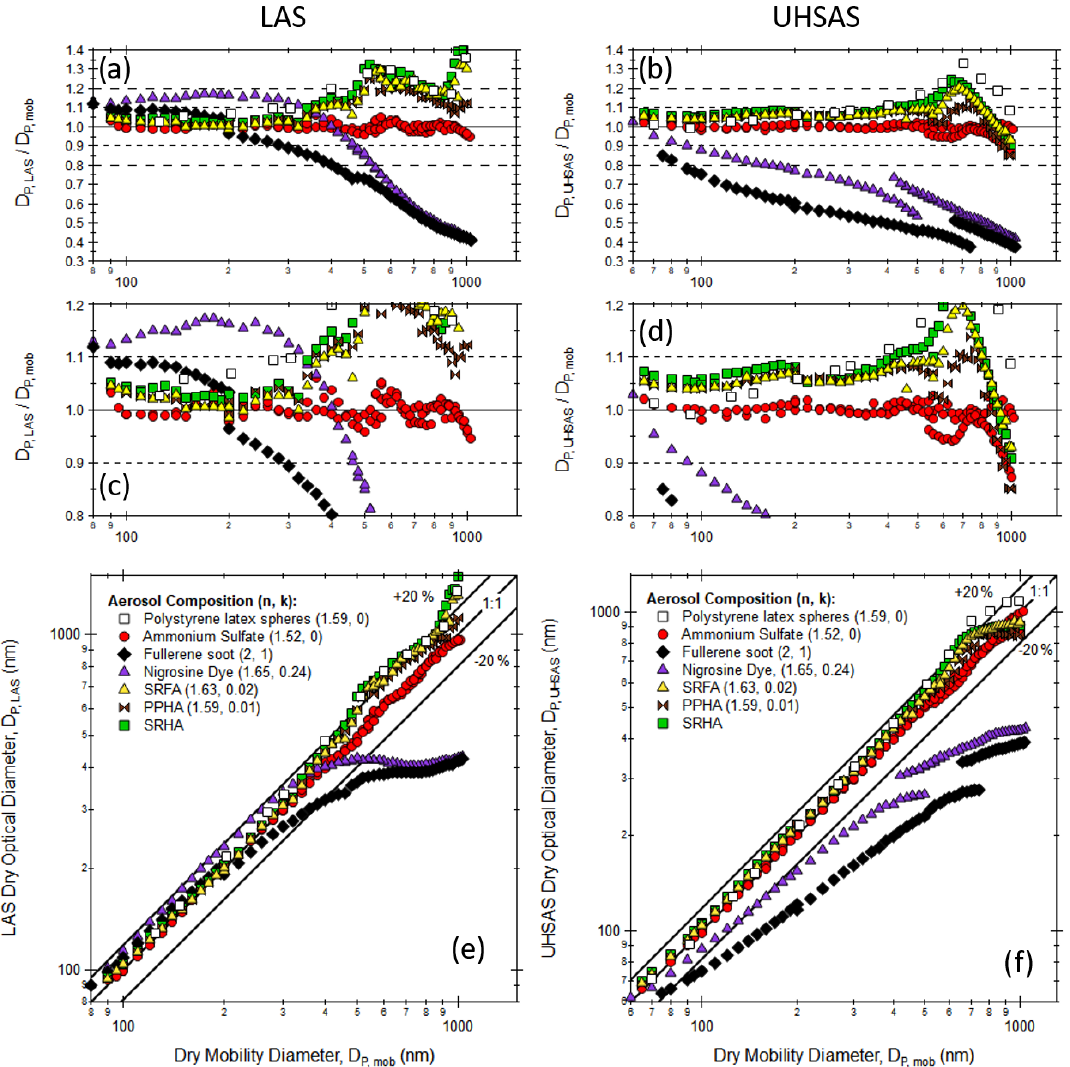
Figure 6. Comparison of optically sized particle diameter as measured by the LAS (a, c, e) and the UHSAS (b, d, f) to the DMA-classified mobility diameter for the light-absorbing aerosol species listed in Table 1. Both optical sizers were calibrated to ammonium sulfate. Pan- els (a) – (d) show the ratio of the optical measurements to the mobility measurements, while the bottommost panels show the data plotted on a 1:1 line ( ± 20% indicated). Panels (a) – (d) show the same information with panels (c) and (d) zoomed in to show additional details. Particles were dried to less than 20% RH with a silica gel diffusion dryer. Raw data for this figure are available in the